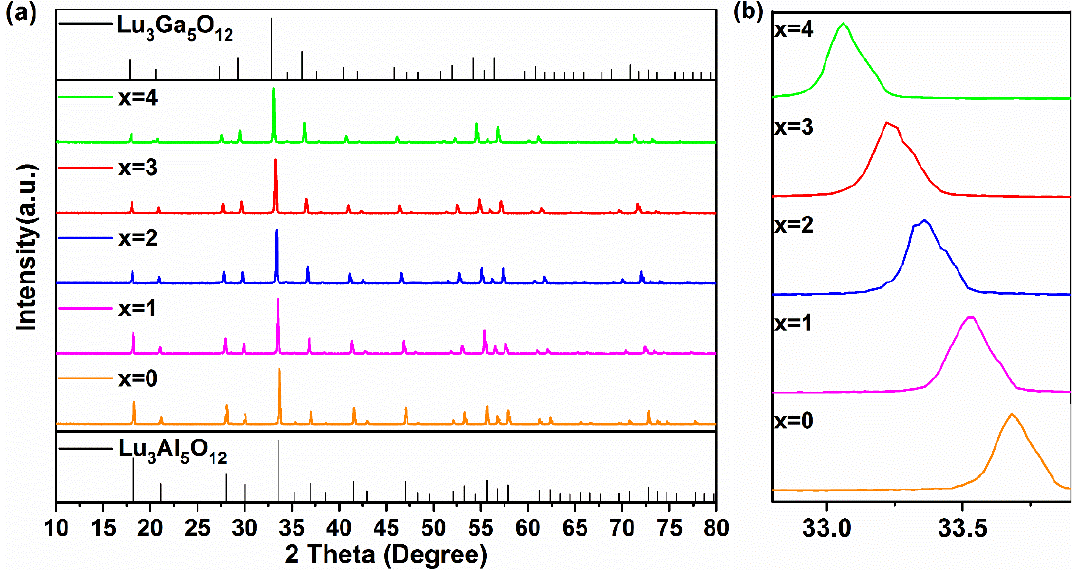
Figure 1. ( a ) The XRD patterns and ( b ) enlarged XRD patterns around 33.5° of the Lu 2 . 94 Ga x Al 5 − x O 12 : 0.06Ce 3+ (x = 0–4) phosphors at 1450 °C for 3 h.